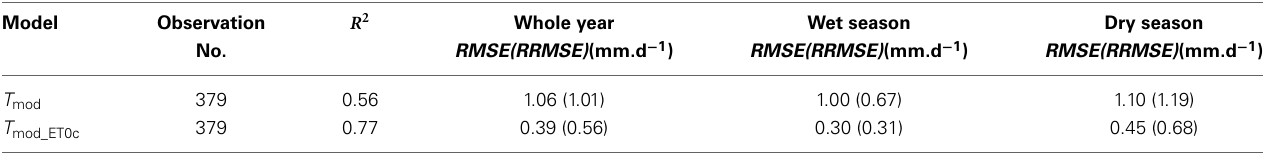
Table 1 | Evaluation metrics of simulations of transpiration according to two frameworks: original BILJOU ( T mod ), simulation with reduction coefficient of ET0 ( T mod_ET0c